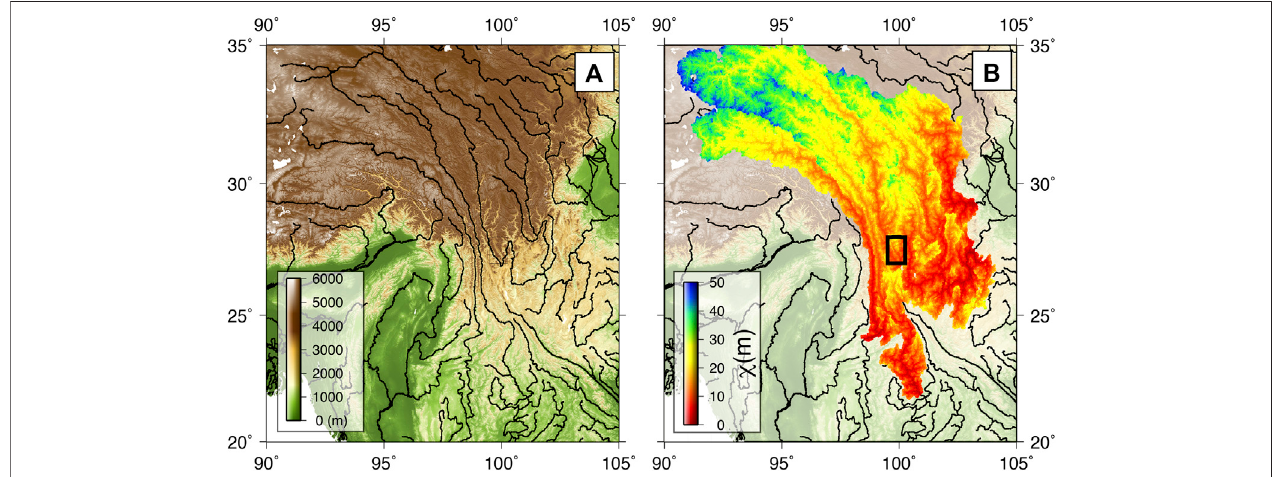
FIGURE3| Thedatasetused fortheanalysis. (A) TheHydroSheds hydrologically conditionedtopographicdatasetwitharesolutionof ∼ 90 m(Lehneretal.,2008). (B) Drainage network topology, upstream drainage area and values of were calculated from this dataset with a baselevel set at 500 m for pixels with an upstream drainage area > 5 km 2 , with an m value of 0.45, and n value of 1 and a scaling area A 0 of 1 m 2 after (Yang et al., 2015). The box outlines the extent of Figure 4 .